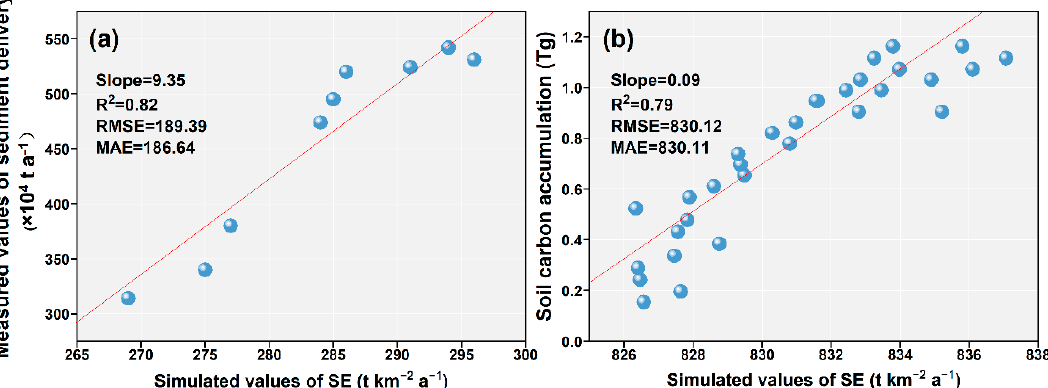
Figure 4. Validation results of SE. ( a ) Relationship between measured values of sediment delivery and simulated values of SE in TRB from 2006 to 2008; ( b ) Relationship between soil carbon accumulation and simulated values of SE. R 2 (Coefficients of determination), RMSE (Root mean square error), MAE (mean absolute error).